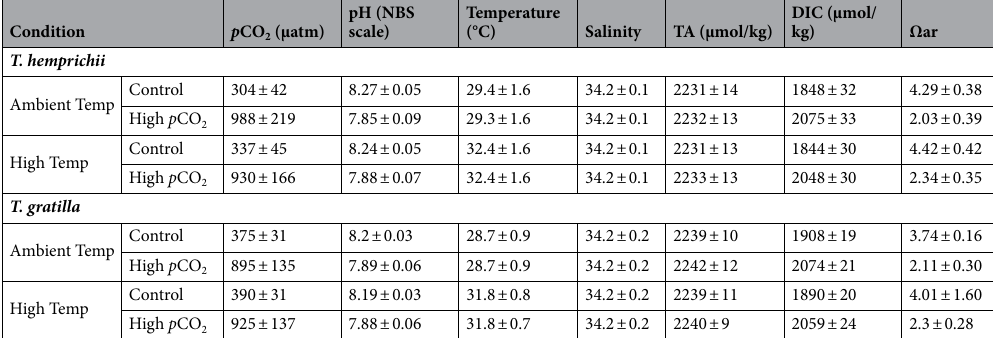
Table 2. Seawater carbonate chemistry during seagrass Thalassia hemprichii and sea urchin Tripneustes gratilla culture. Seawater p CO 2 , DIC and Ω ar were calculated from the measured pH and total alkalinity (TA) using CO2SYS. Values represent mean ±